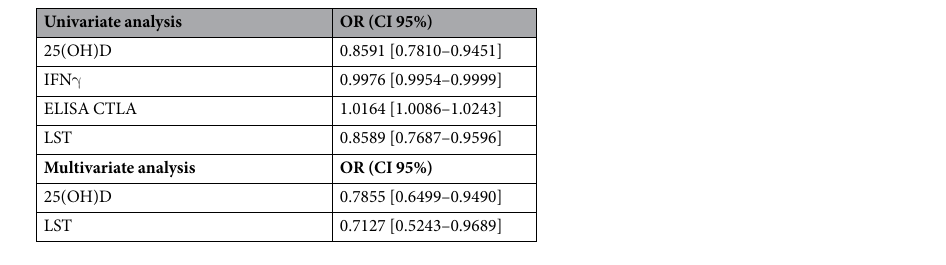
Table 2. Risk factors for canine leishmaniasis. OR: Odds Ratio; CI: Confidence